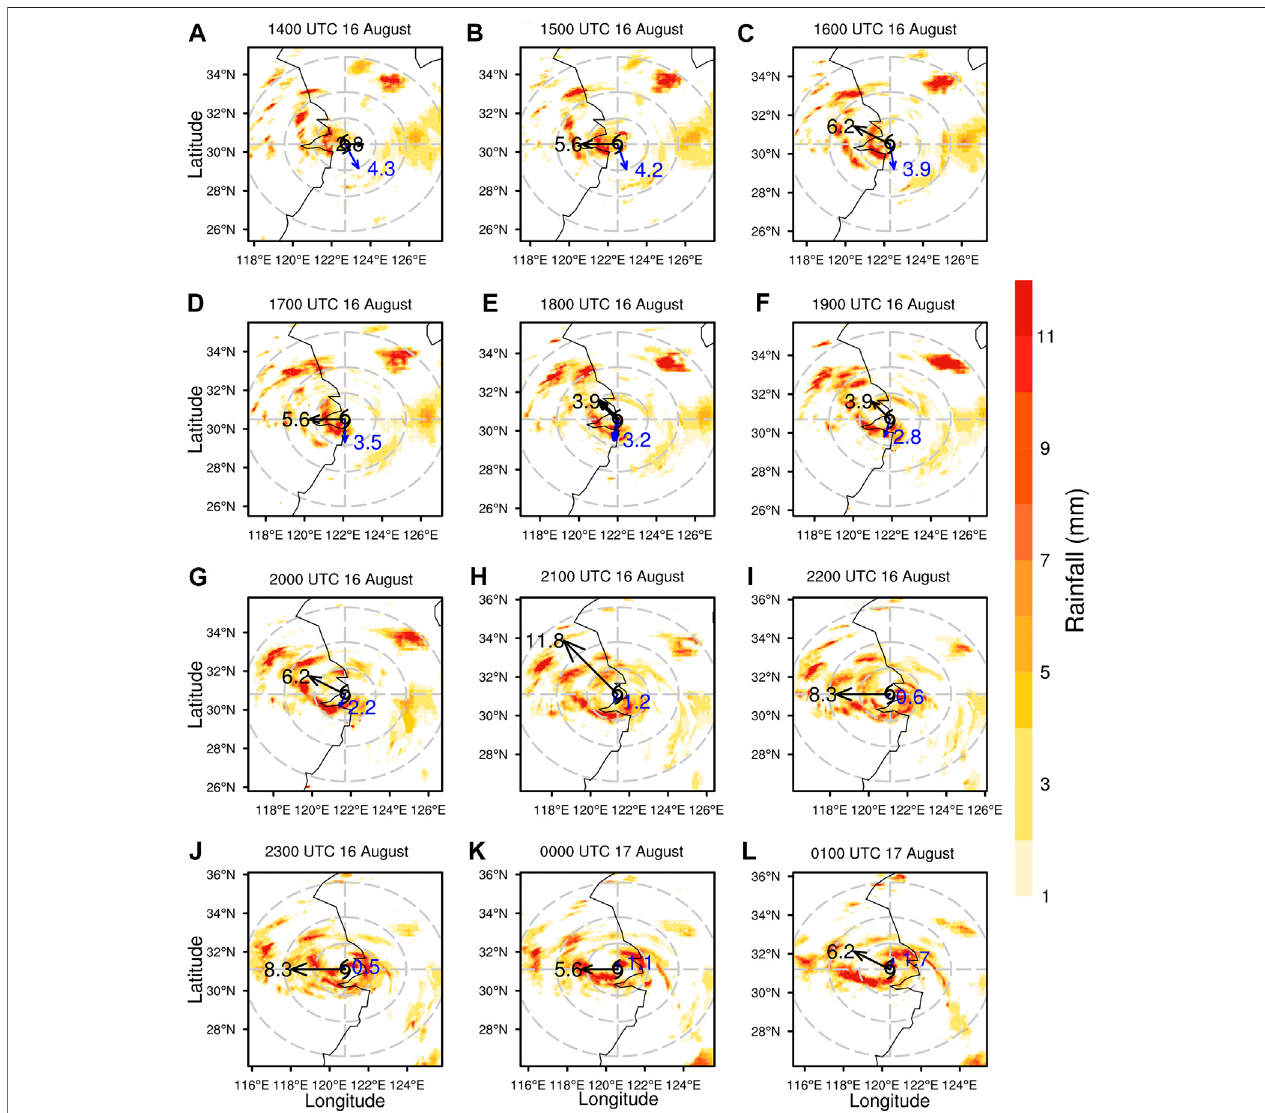
FIGURE6| Hourlyrainfallevolution(shading,mm)at (A) 1,400, (B) 1,500, (C) 1,600, (D) 1700, (E) 1800, (F) 1900, (G) 2000, (H) 2,100, (I) 2,200, (J) 2300UTC16 August, (K) 0000 (L) 0100 UTC 17 August. Grey dashed concentric circles are 150, 300, and 500 km from the storm center. Black arrows and numbers denote the stormmotionvectorsandspeeds(ms − 1 ).Bluearrowsandnumbersrefertothedirectionsandmagnitudes(ms − 1 )ofthedeeplayerVWSbetween300and850 hPa.The cyclone symbol indicates the storm center at the given